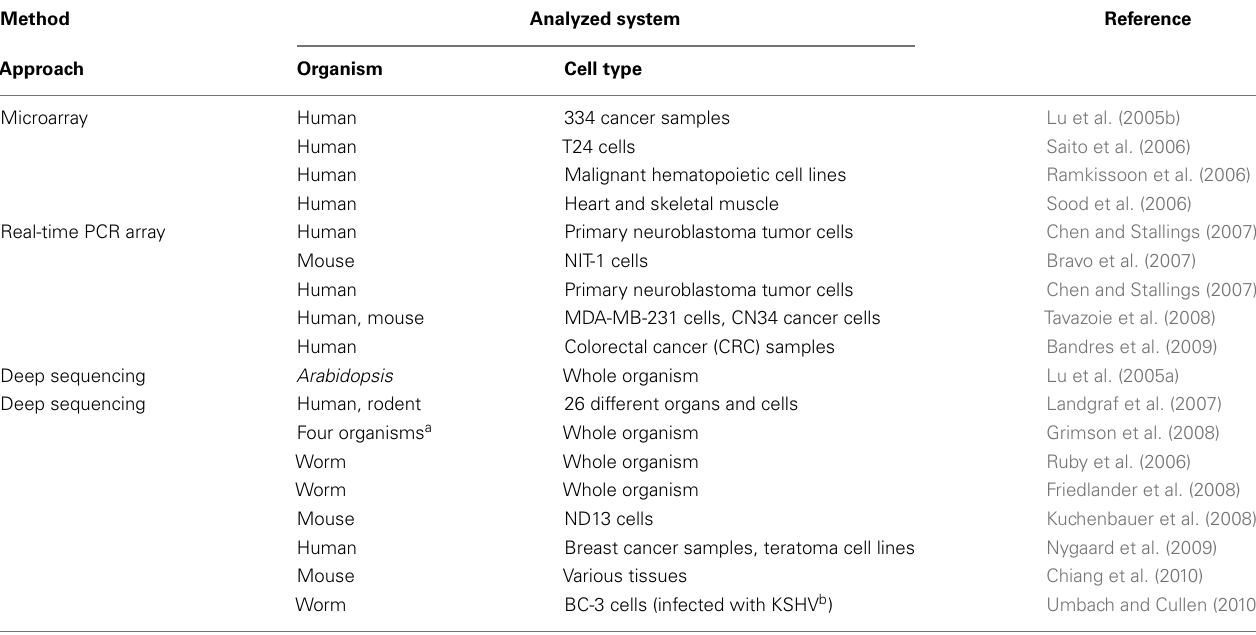
Table 2 | Examples of studies using transcriptome analysis to identify miRNA